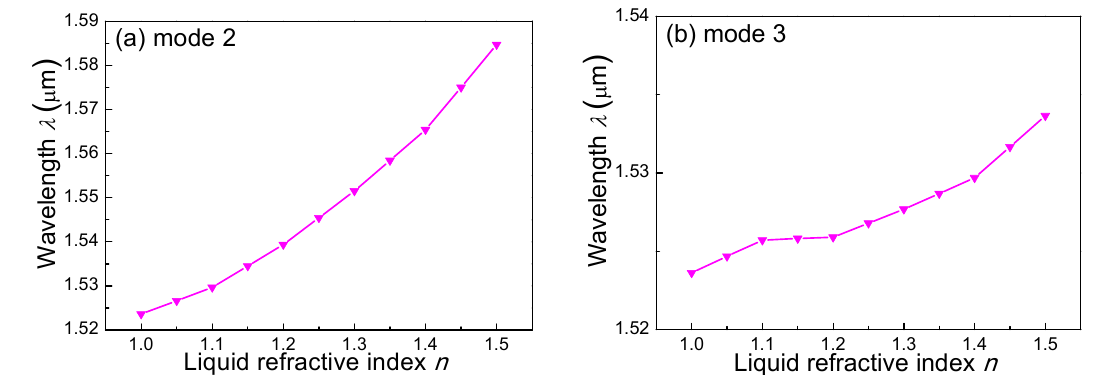
 (b) mode 3 Figure 5. For mode 3, curves of ( a ) group index 𝑛 (cid:2917) , and ( b ) absorption enhancement factor 𝛾 versus the normalized frequency. 4. Slow-Light Enhanced Gas Sensing Performance Analysis